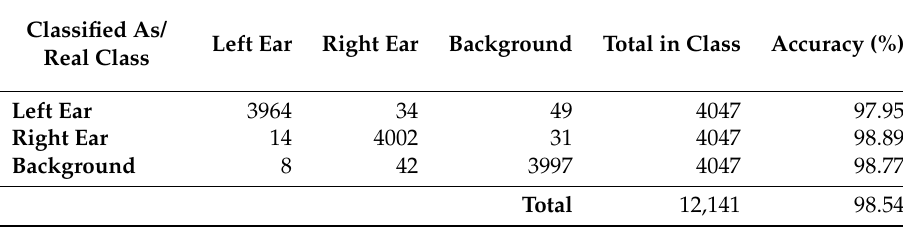
Table 6. Final confusion matrix of the testing data fold.